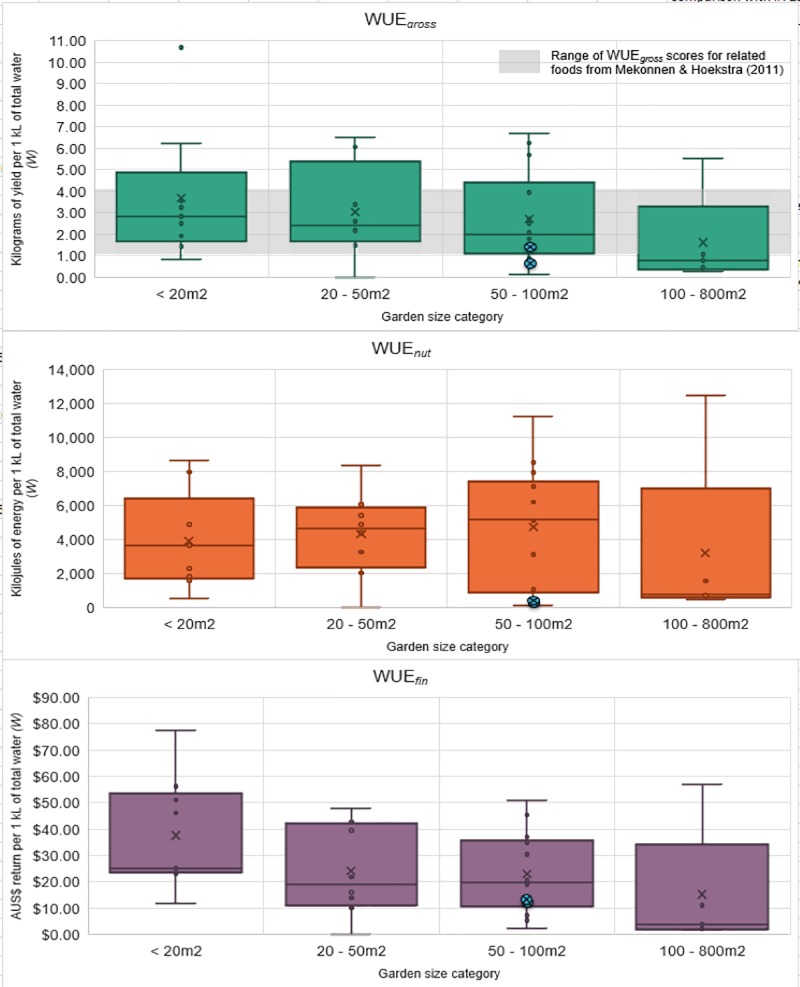
The WUEgross, WUEnut and WUEfin results for the garden size categories.The blue circles represent the WUEgross and WUEnut values of the two gardens from the Cleveland et al. [5] study as previously calculated in [16], while WUEfin results have been adjusted to the 2018 AUS$ value. The pale grey band represents the global average WUEgross scores for ‘vegetables’, ‘roots and tubers’ and ‘fruits’ from Mekonnen and Hoekstra [36].